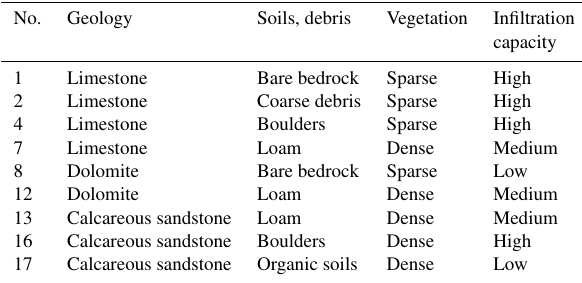
Table 2. Hydrological response units of Fig.